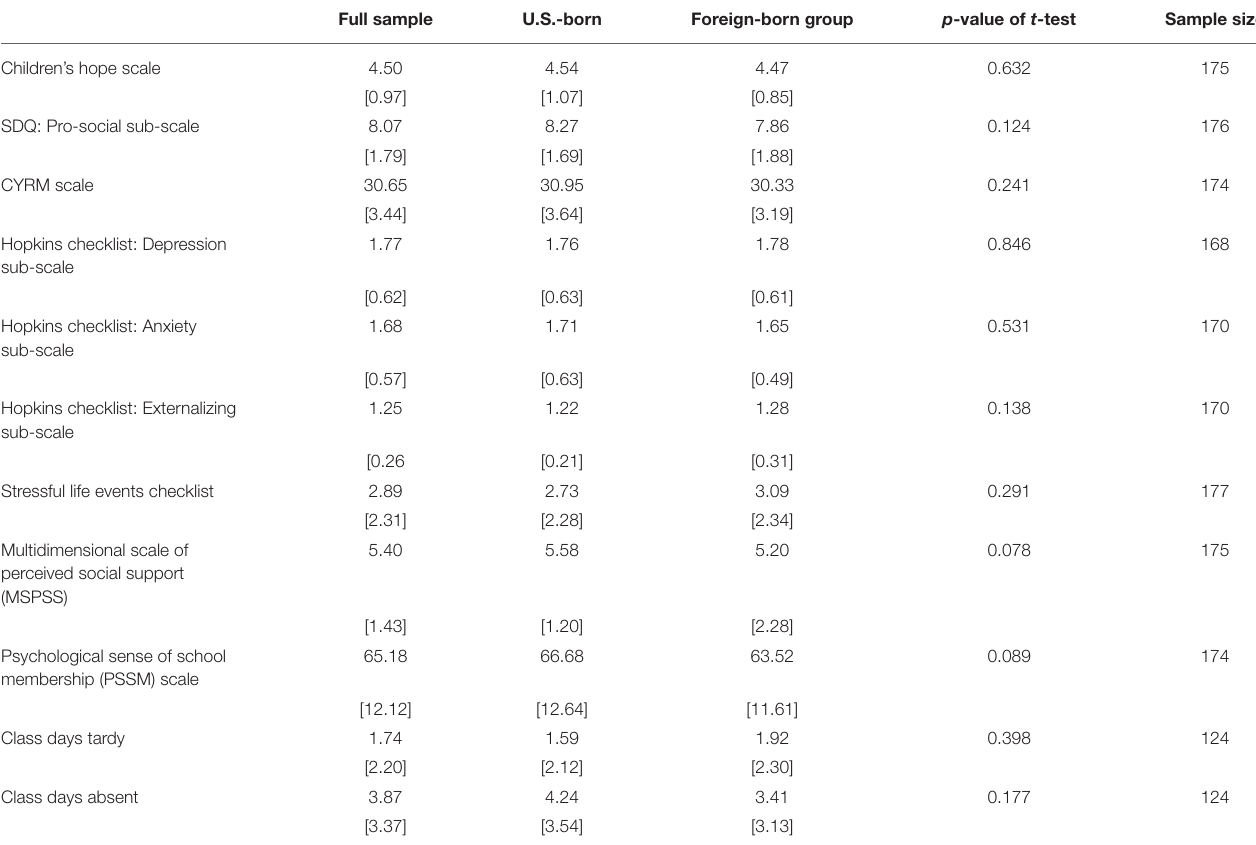
TABLE 4 | Psychosocial and attendance outcomes, by